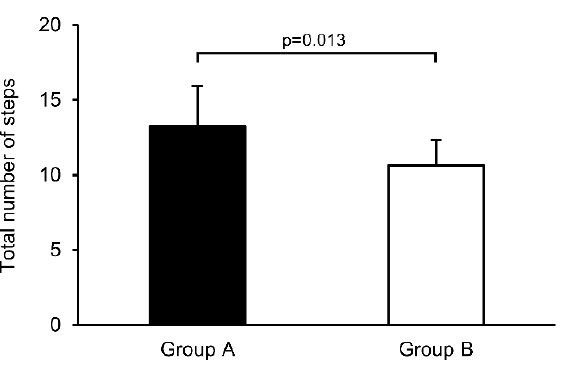
Figure 3. Total number of steps in both groups. Data are expressed as mean ± standard